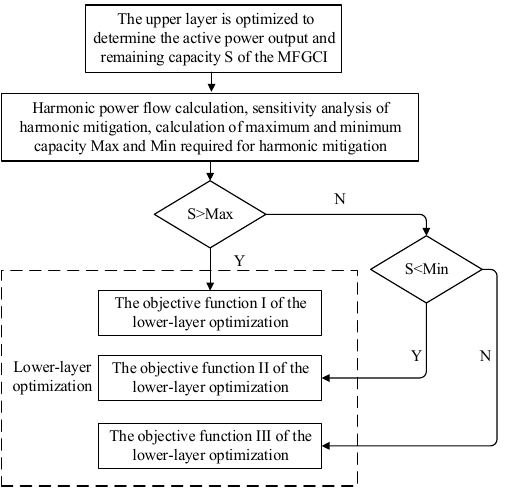
Figure 2. The choice of three objective functions for lower-layer optimization.